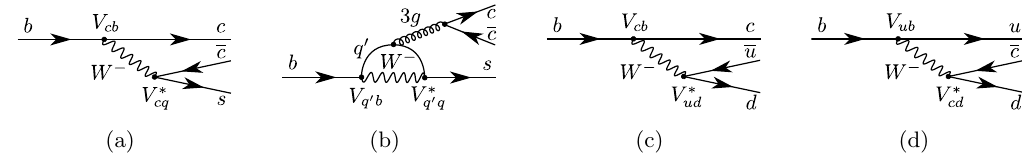
Figure 1 . The tree (a) and loop (b) contributions to the b and suppressed b